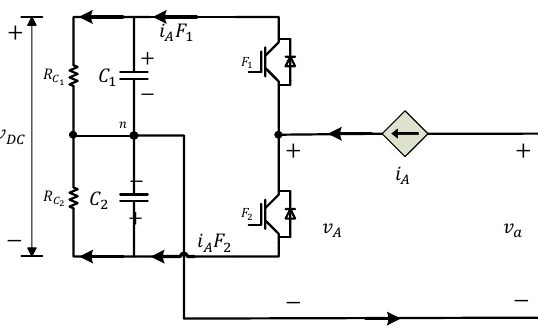
Figure 2. TLSC SAPF control structure.